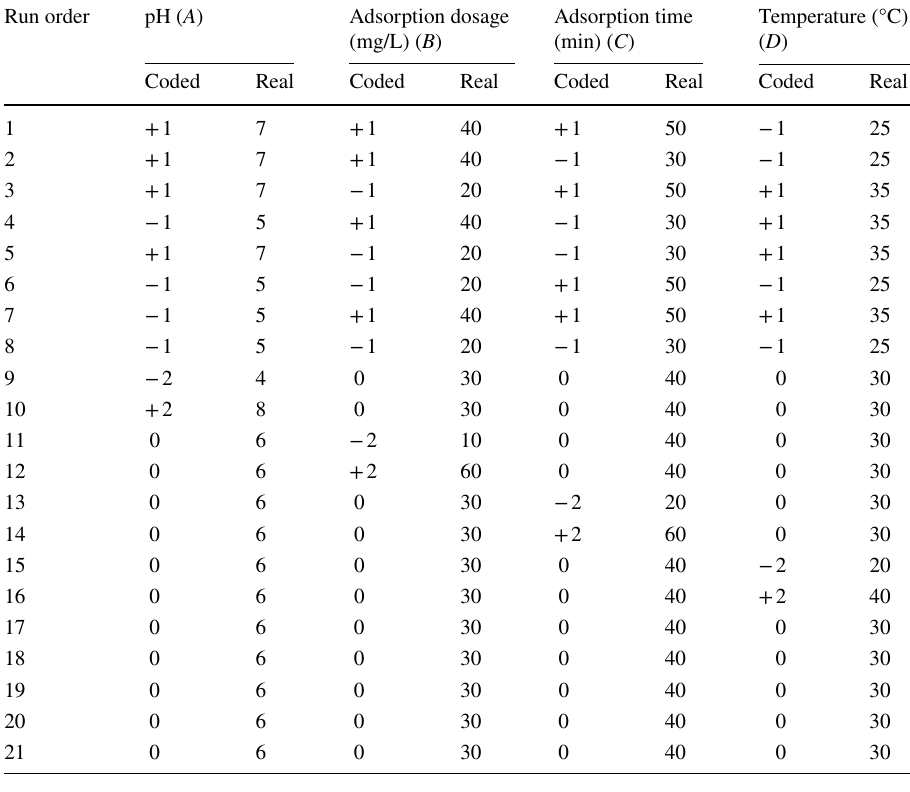
Fig. 1 SEM images of a raw coal and b activated coal after DS